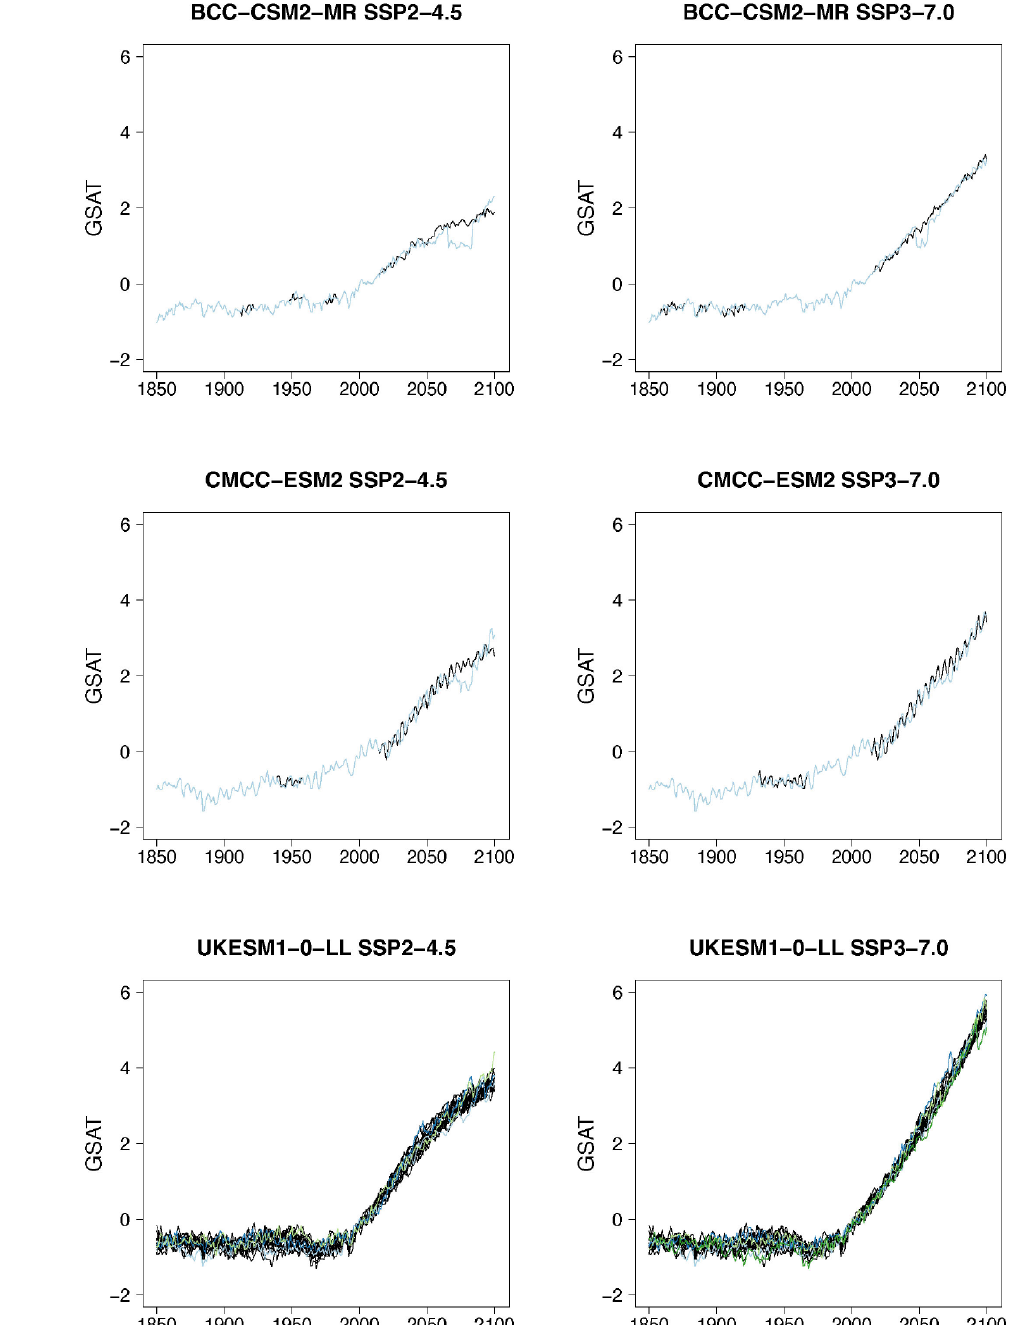
Figure B2. Examples of target (black lines) and stitched (colored) GSAT time series for ESMs in the PANGEO archive that ran at least one trajectory along the Tier 1 experiments of ScenarioMIP (SSP1-2.6, SSP2-4.5, SSP3-7.0, SSP5-8.5). We use the two bracketing scenarios and emulate trajectories that follow the two intermediate